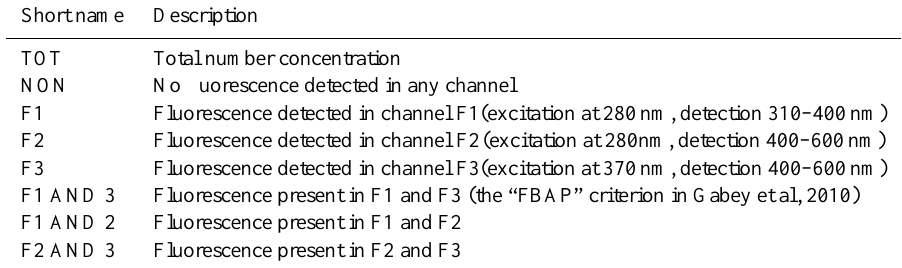
Table 1. The fluorescent and non-fluorescent particle types specified in the